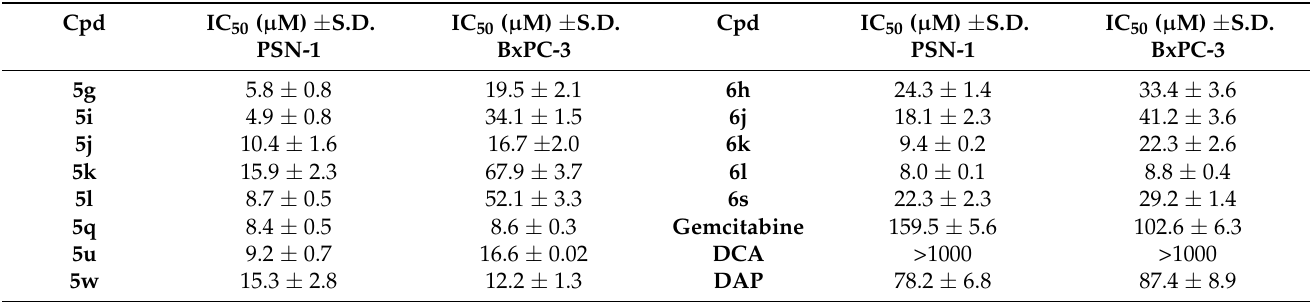
Table 3. Antiproliferative activity of the most representative compounds against PSN-1 and BxPC3 cancer cells evaluated in a 3D cytotoxicity